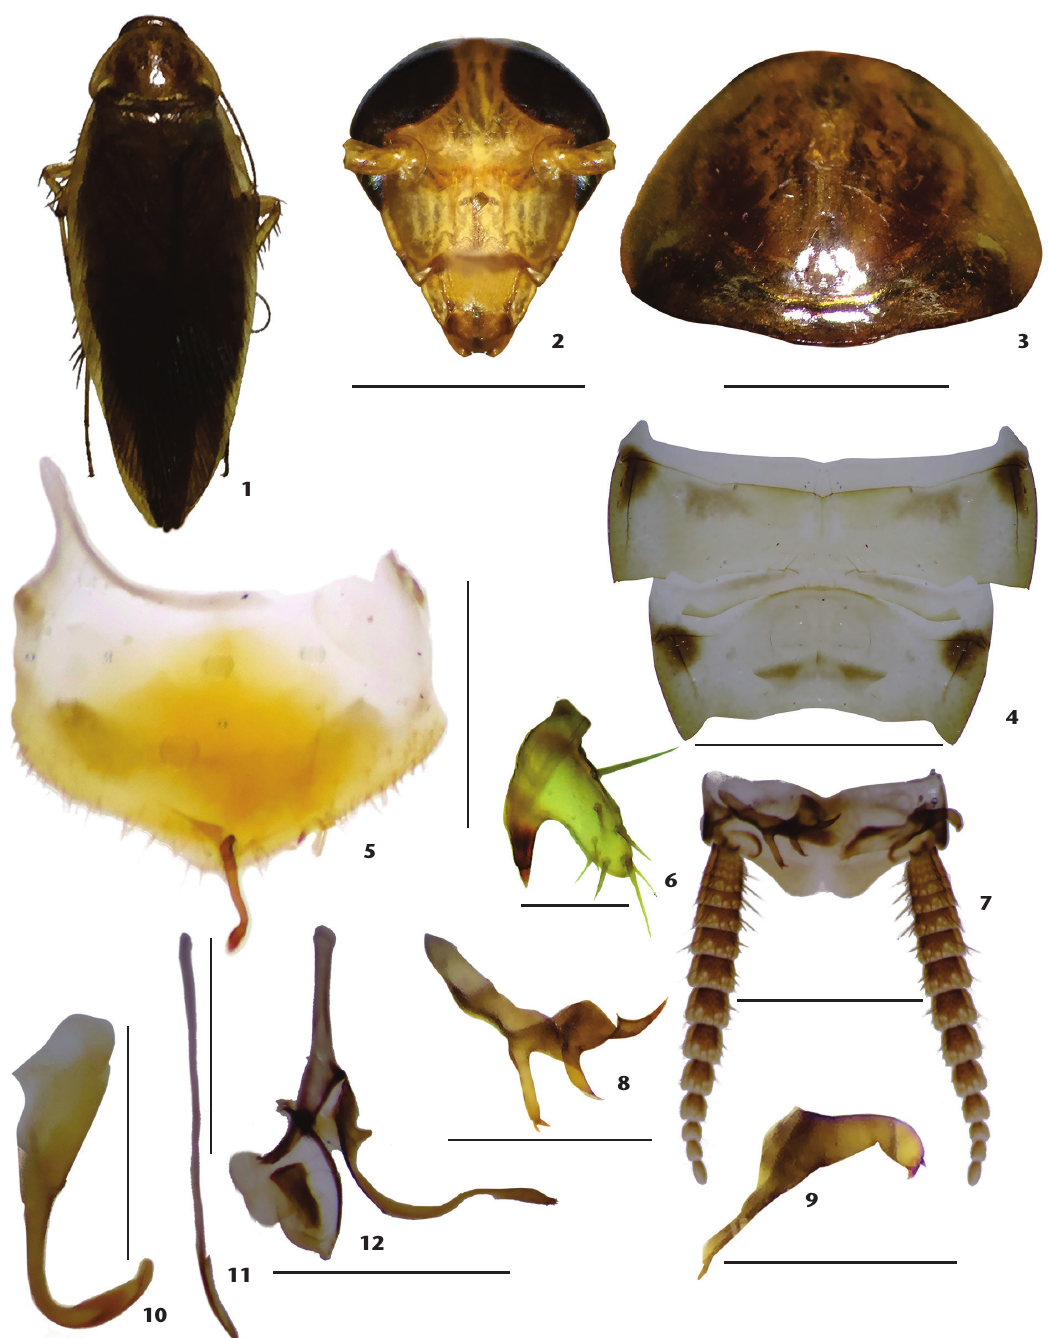
9Figures 1-12. Xestoblatta urucuana sp. nov. , holotype male: (1) habitus, dorsal view, length 18.4 mm; (2) head, ventral view; (3) prono- tum, dorsal view; (4) tergal modification of the tergite VII, dorsal view; (5) subgenital plate, ventral view; (6) left style, ventral view; (7) supra anal plate, dorsal view; (8) left paraproct, dorsal view; (9) right paraproct, dorsal view; (10) left phallomere (L3), dorsal view; (11) median esclerite (L2vm), dorsal view; (12) right phallomere (R2), dorsal view. Scale bars: 2 = 2.5 mm, 3-4 = 3.0 mm, 5, 11-12 = 1.5 mm, 6 = 0.15 mm, 7 = 1.8 mm, 8-9 = 0.8 mm, 10 = 0.7 ZOOLOGIA 33(6): e20160041 | DOI: 10.1590/S1984-4689zool-20160041 | December 15, 2016 3 /